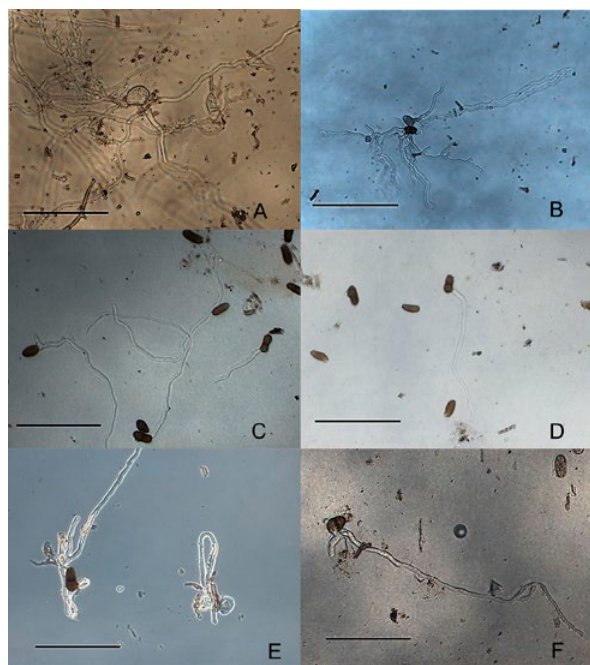
Figure 4. Hyphal branches observed in the fungi Lasiodiplodia gila- niensis (A and B), Diplodia seriata, (C and D) and D. corticola (E and F), after 8 h growth on Vogel’s Minimum Medium supplement- ed with (A, C, and E) or without grapevine wood (B, D, and F). Increased numbers of hyphal branches were observed in the media containing wood. Bars = 50 μm.